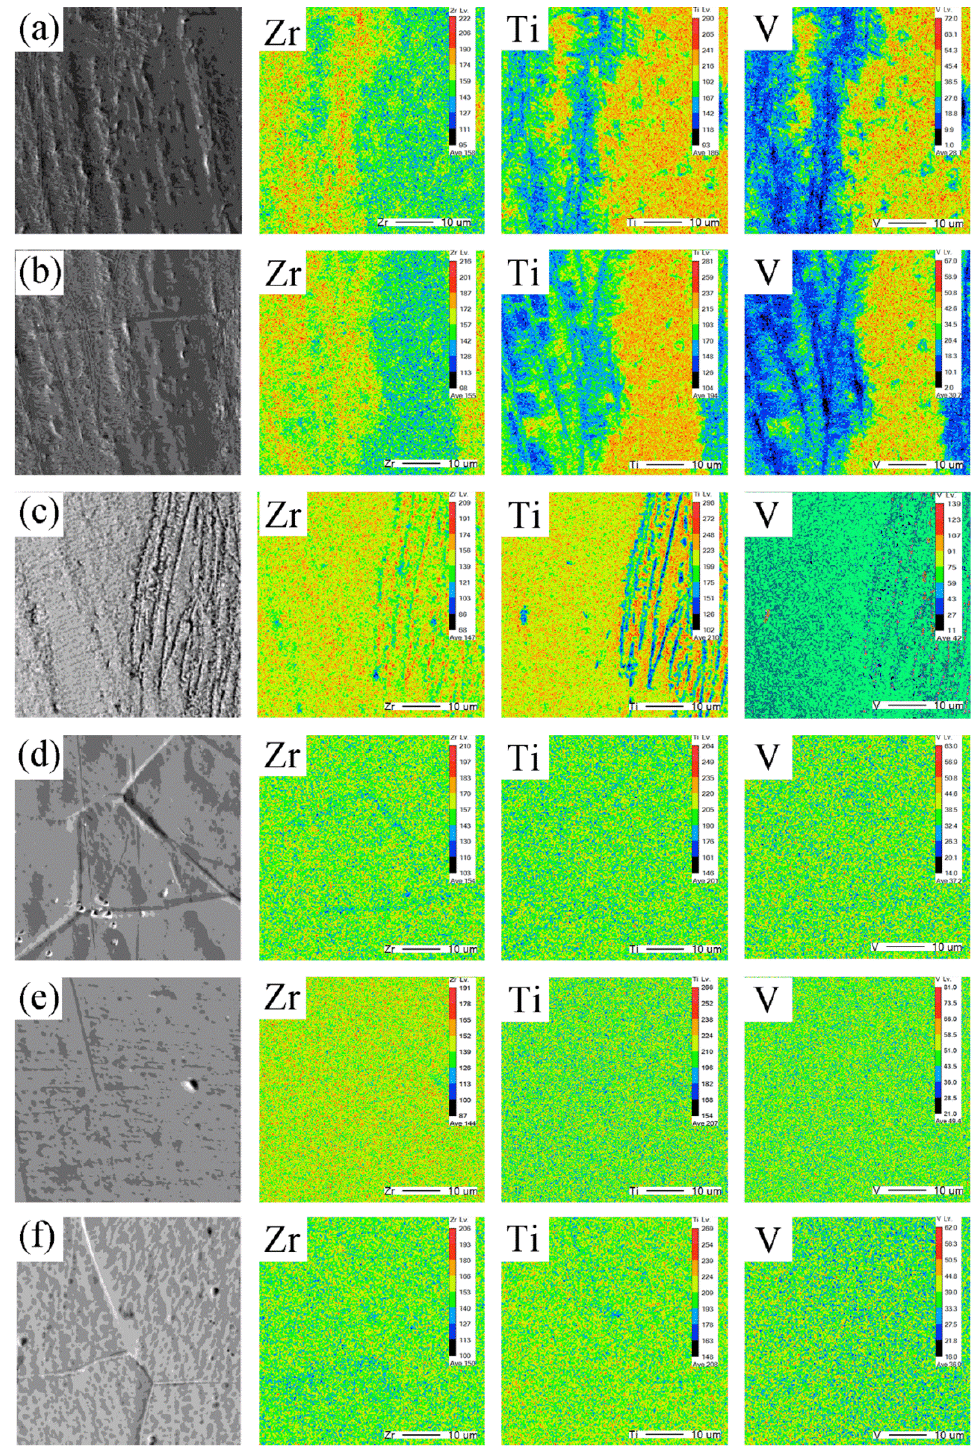
Figure 4. EPMA images of annealed Zr-Ti-8V alloys: ( a ) 400 °C; ( b ) 450 °C; ( c ) 500 °C; ( d ) 600 °C; ( e ) 700 °C; ( f ) 800 °C.